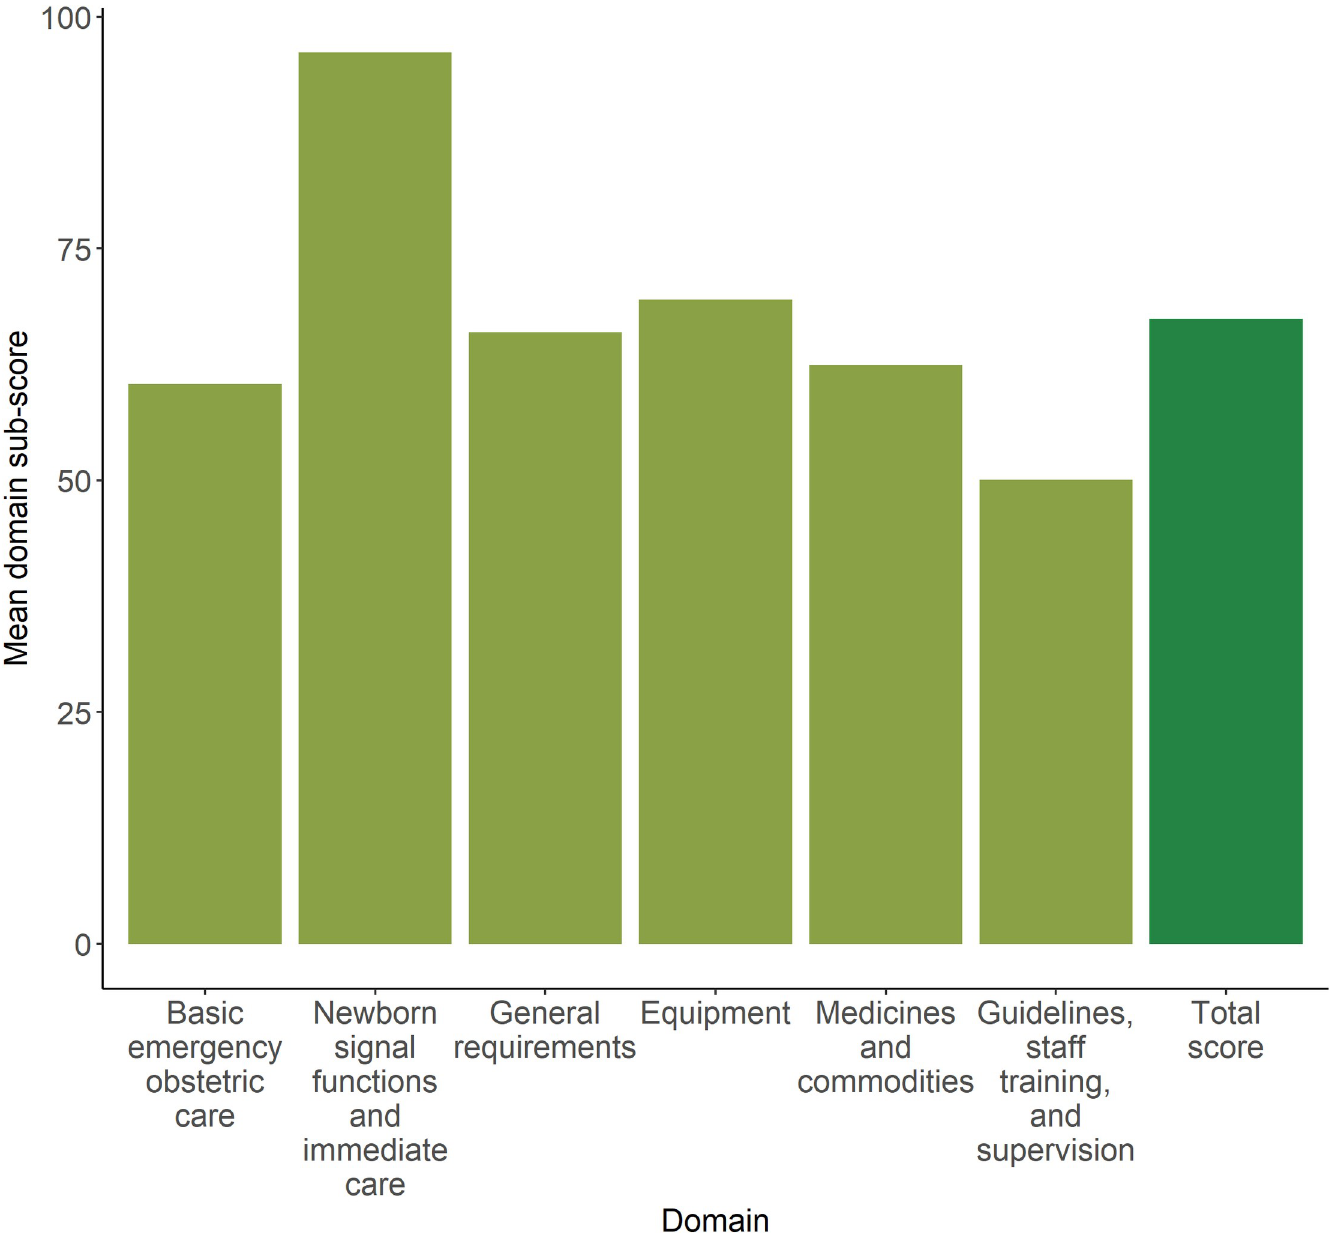
Fig 2. Mean service readiness scores and domain sub-scores (and 95%Cis) for facilities providing care around the time of birth (n = 540).